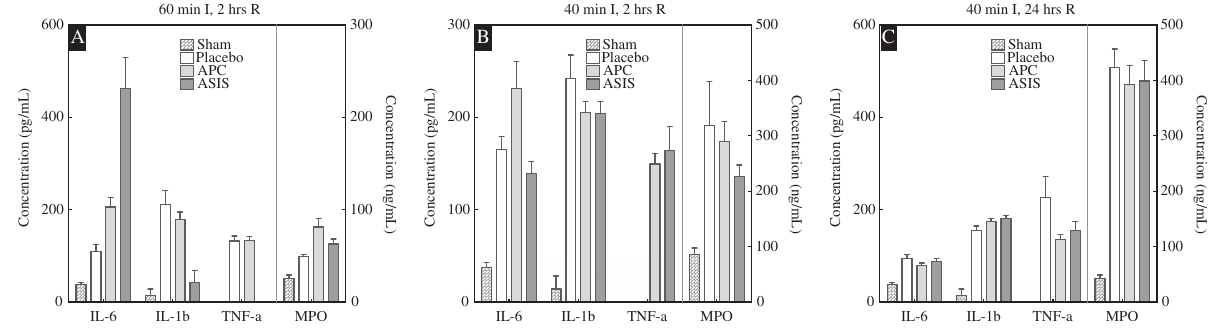
Figure 4. Effect of APC and ASIS on in fl ammatory markers after Panel A: 1 hr of ischemia and 2 hr of reperfusion, Panel B: 40 min of ischemia and 2 hr of reperfusion, and Panel C: 40 min of ischemia and 24 hr of reperfusion. Values are mean ± SEM, n = 6, * sham vs. placebo, # ASIS vs. placebo, $ APC vs. placebo, p <